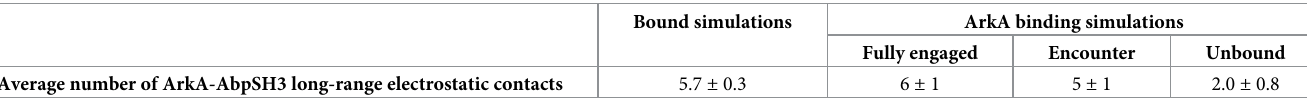
Table 4. Average number of long-range electrostatic contacts for different